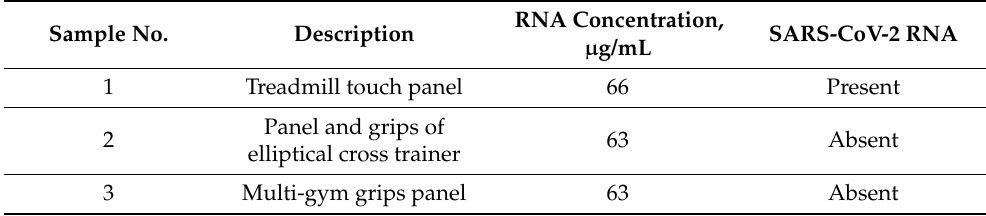
Table 2. Detection of SARS-CoV-2 on the fitness center surfaces. RNA Concentration, SARS-CoV-2 RNA Sample No. Description µ g/mL 1 Treadmill touch panel 66 Present Panel and grips of 2 63 Absent elliptical cross trainer 3 Multi-gym grips panel 63